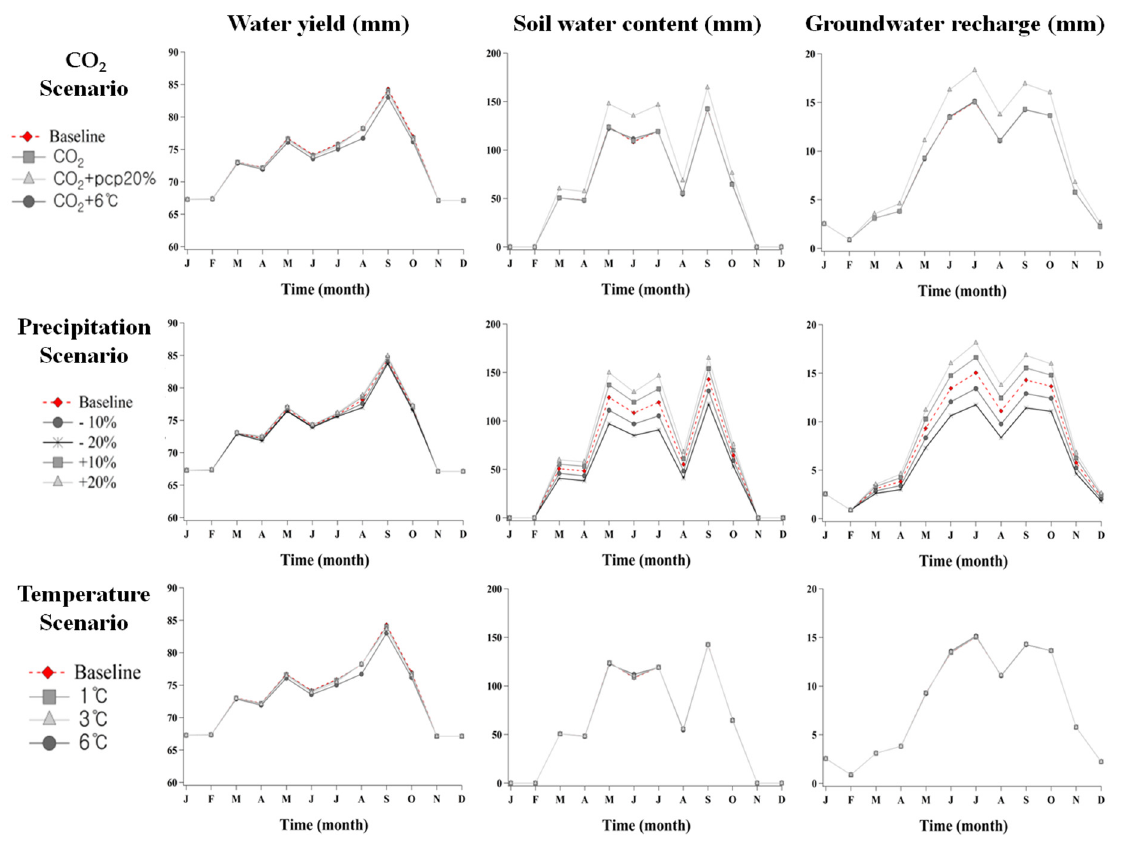
Figure 4. Water yield, soil water content, and groundwater recharge of Chao Phraya River basin under climate sensitivity